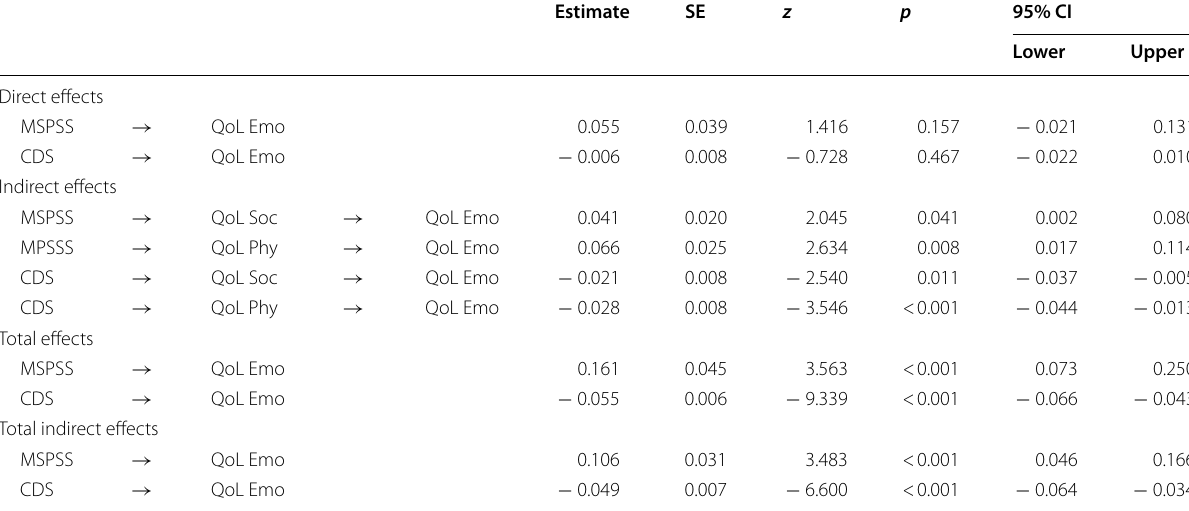
The confidence interval for the indirect effect is a BCa bootstrapped CI based on 5000 samples. Qol Emo QoL emotional domain, QoL Soc QoL social domain, QoL Phy QoL physical